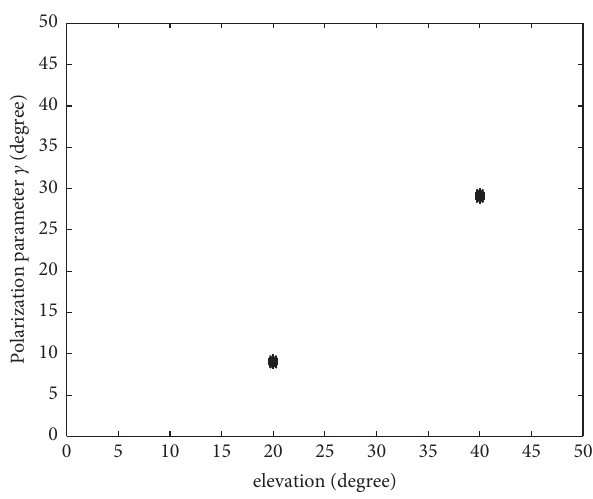
Figure 4: Scatter plot of DOA and polarization parameter c .